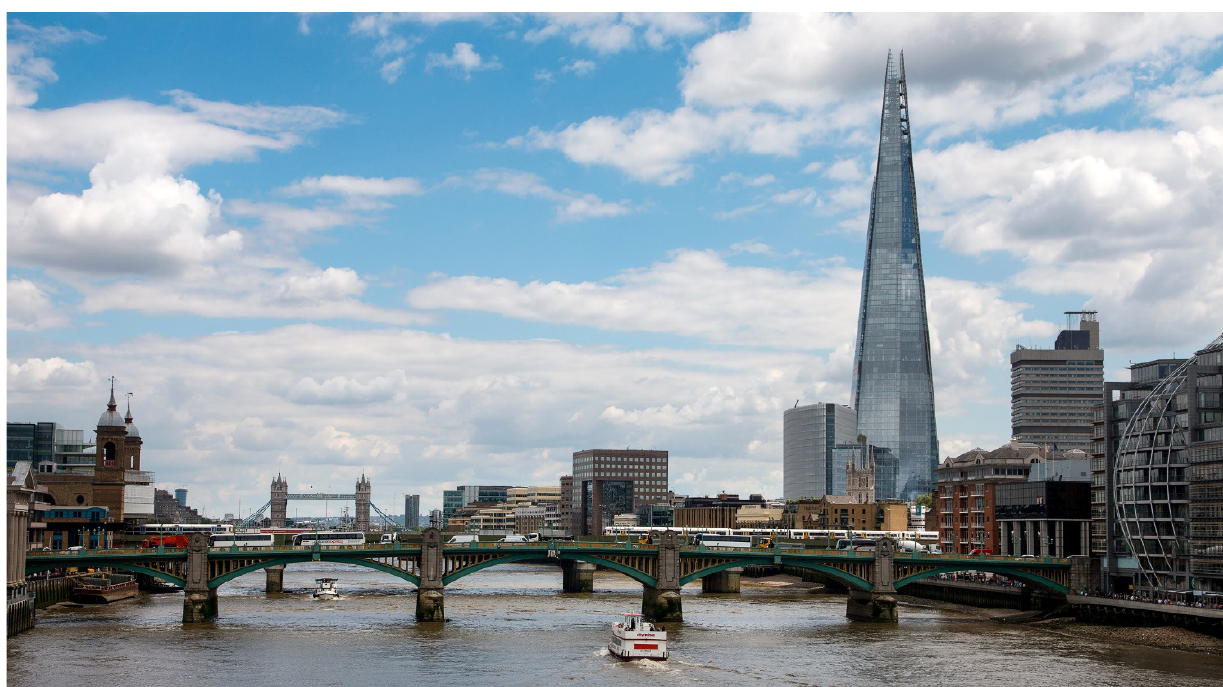
Figure 4. The Shard, London. Source: Photo from © Moment Open/Getty Images. a cardinal virtue even though it barely stands up